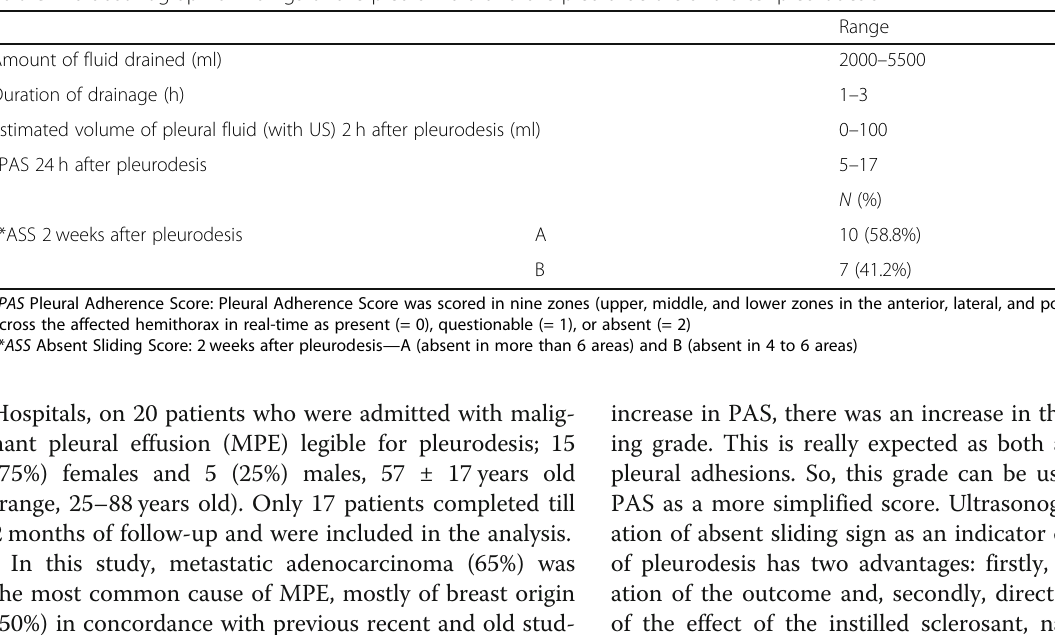
Table 2 Ultrasonographic findings of the pleural fluid and the pleura before and after pleurodesis